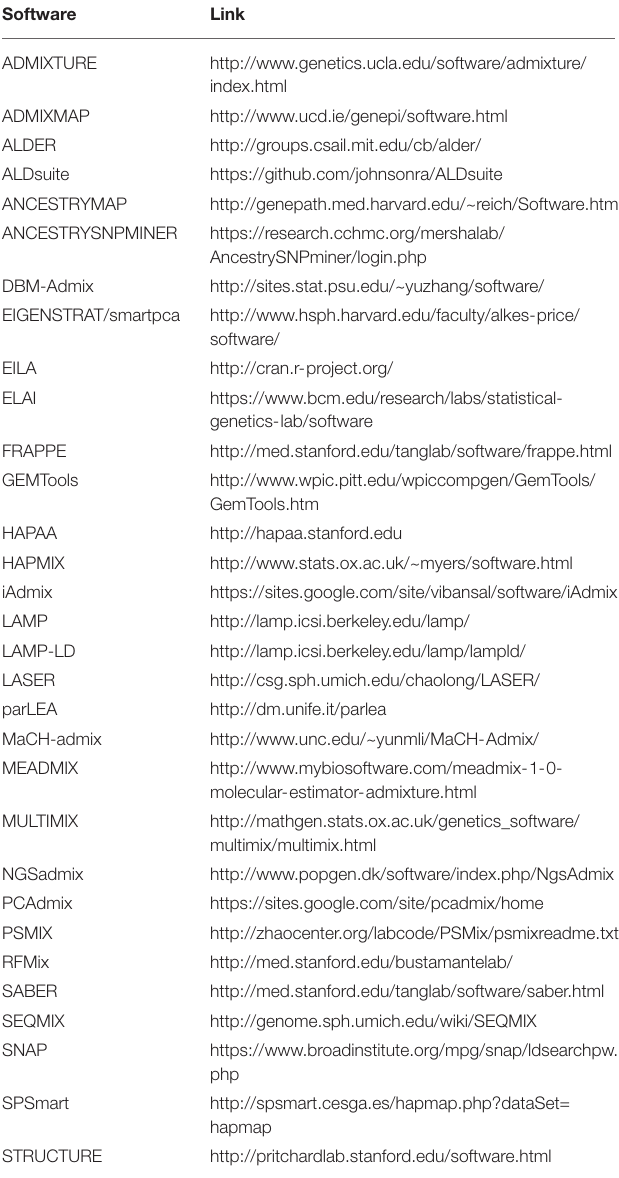
TABLE 2 | Lists of publicly available software usefulness in developing ancestry informative markers, global and local ancestry inferences, and admixture mapping with a link to software